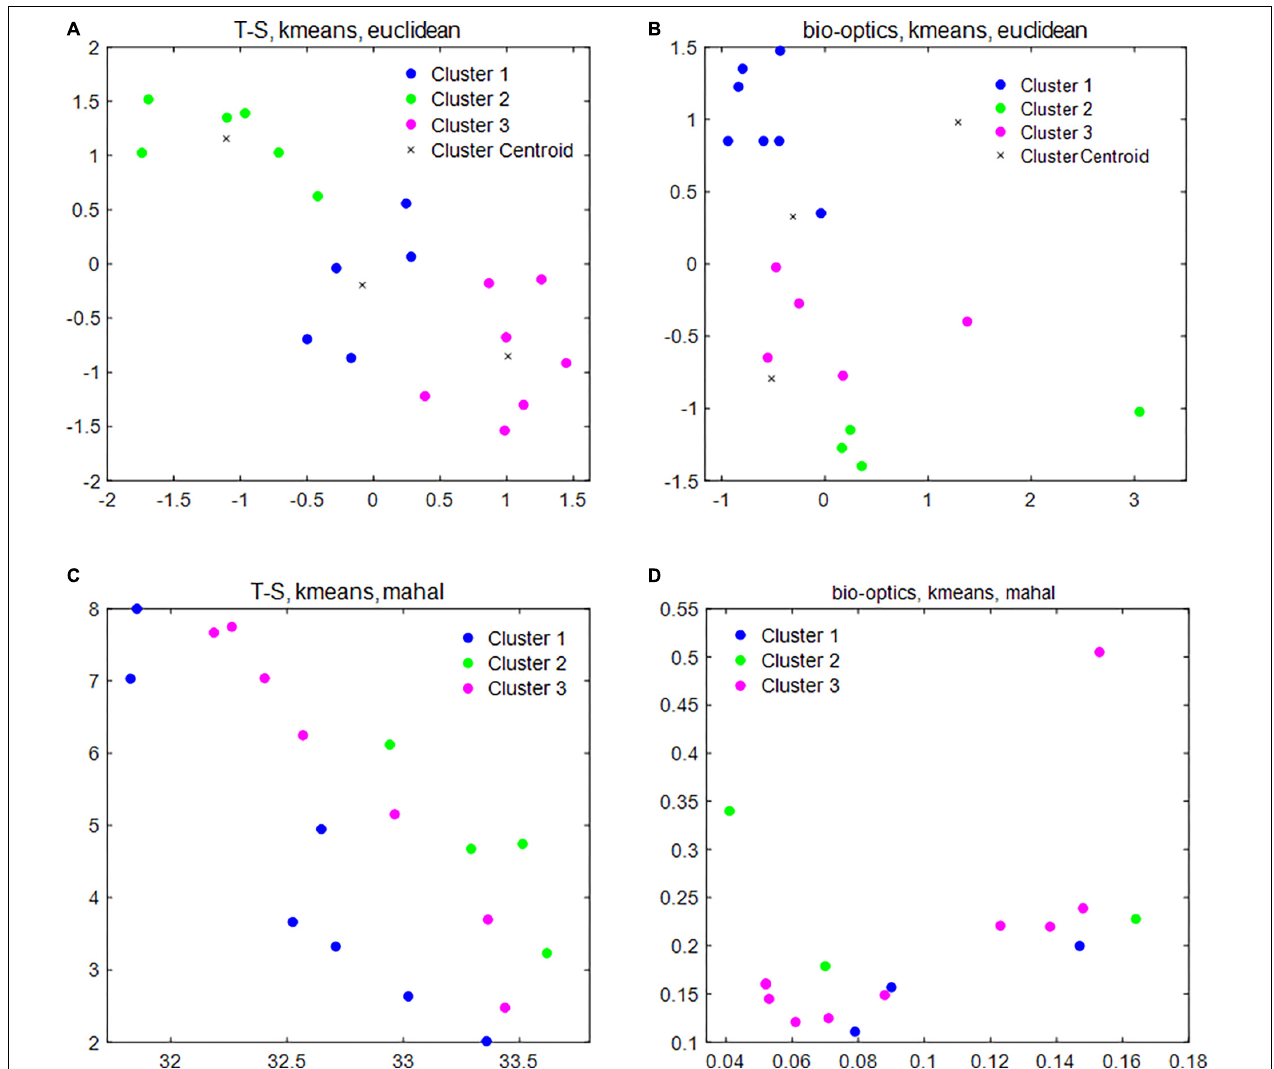
FIGURE 11 | Cluster analysis of hydrographic and bio-optical matrices. Scatter plot representing clusters derived using k -means clustering of the hydrographic (A,C) and bio-optical matrices (B,D) using the Euclidean (A,B) and Mahalanobis distance metrics (C,D)